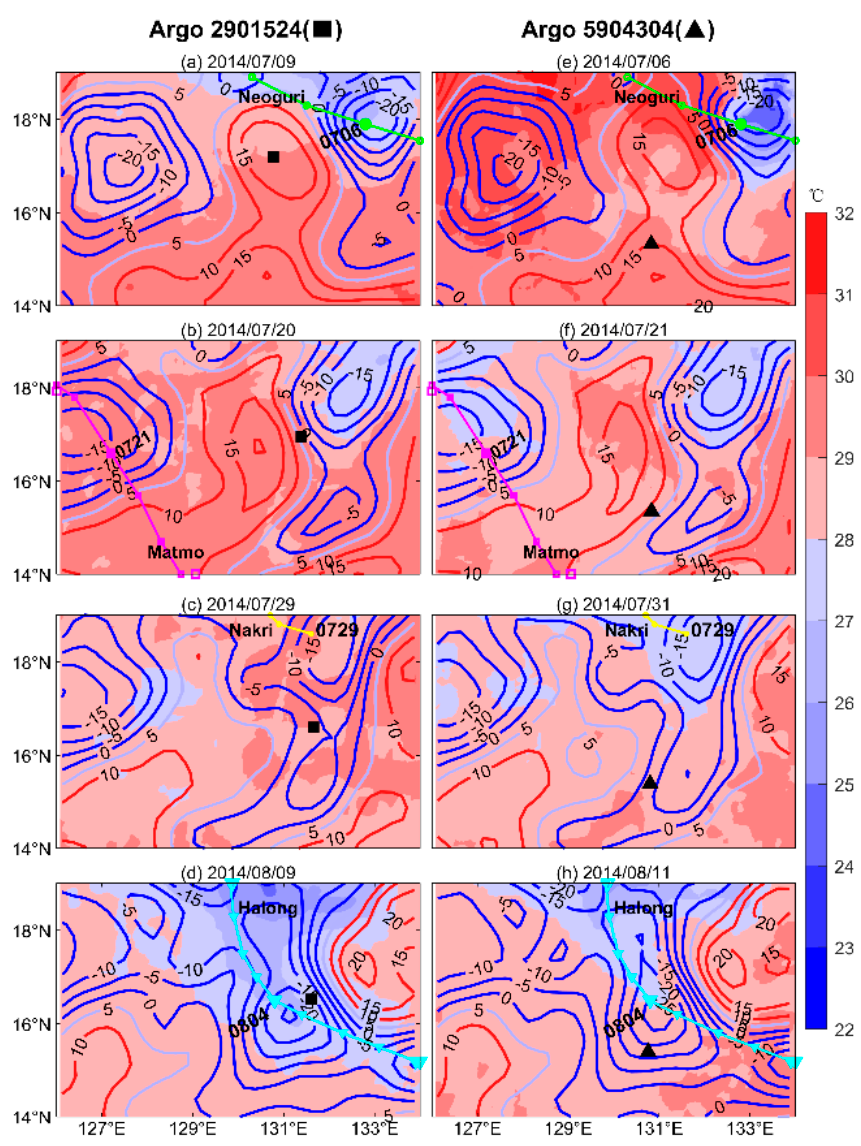
Figure 5. Times and positions of Argos 2901524 (a-d) and 5904304 (e-h) in the CE.